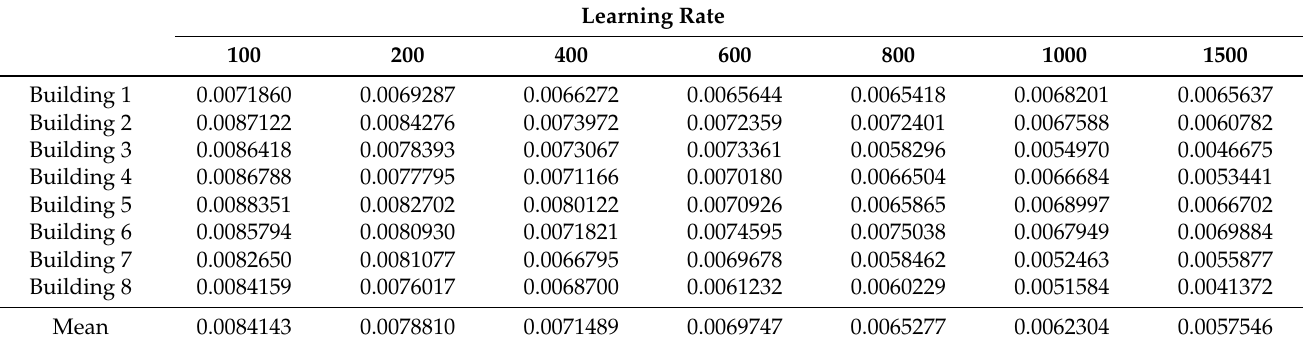
Table 4. Mean square error of the number of epochs.